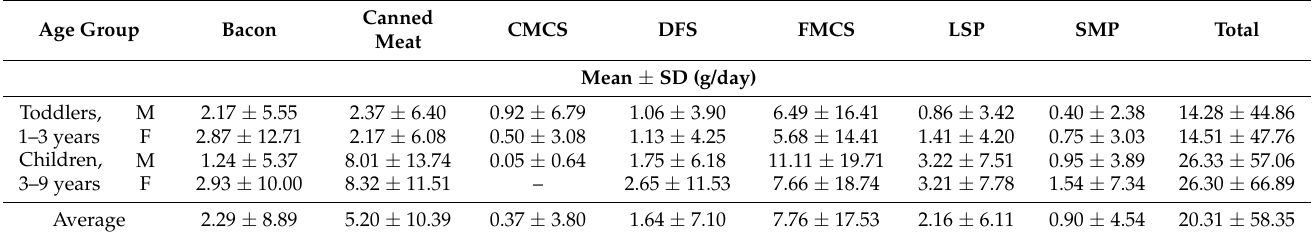
Table 2. The average intake of processed meat products by children population (g/day).